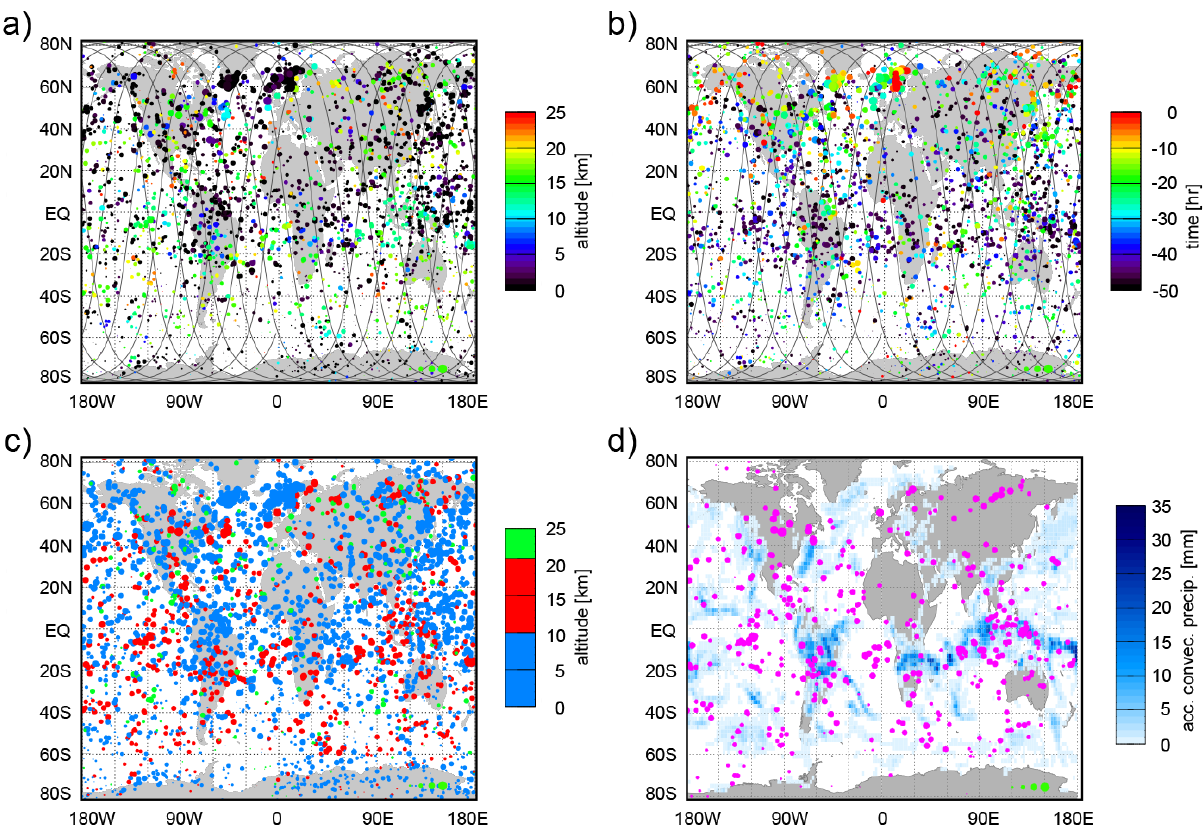
Figure 3. Global maps of (a) the ray-termination location and the altitude [km] to which rays can be backtraced (lowest traceable altitude: LTA) for 29 January 2008, (b) the time to reach the ray termination in hours, (c) altitude, as (a) , but with reduced color scale and (d) only the rays which terminate between 12km and 18km altitude overplotted on accumulated precipitation [mm] for 27 January. Precipitation is smoothed by a box-average of 9 × 9 points. The size of the dots is a measure of the GWMF at 25km altitude. In order to determine the value, please refer to the green dots in the lower right corner of the panels which indicate 0.01, 0.1, 1 and 10mPa, respectively (scale is equal for all panels). In panel (b) black indicates 50h or